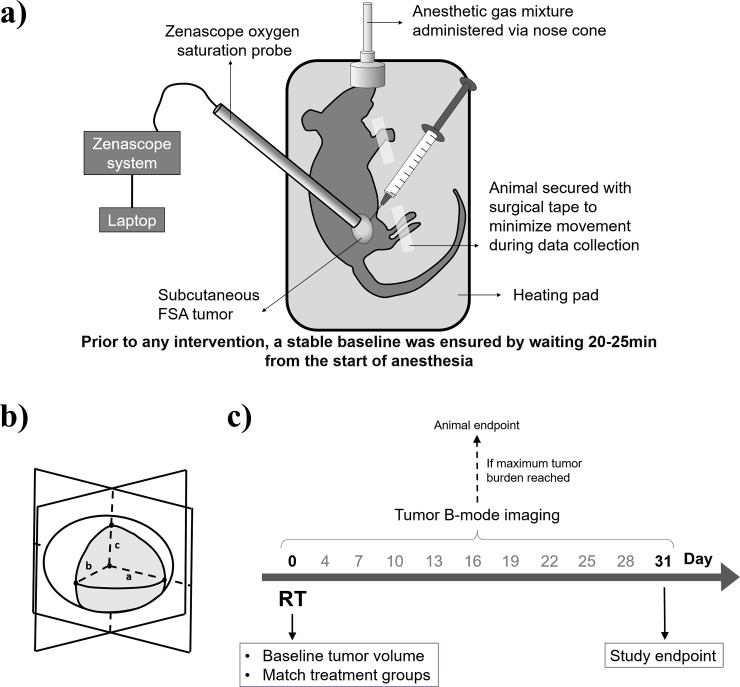
Experimental procedures.a) Schematic of the experimental set-up used for in-vivo hypoxia modulation measurements using the Zenascope system. b) Schematic of tumor volume assessment via B-mode ultrasound imaging. Two cross-sectional images were acquired and lengths a, b and c were used to calculate tumor volume. c) Radiotherapy pre and post-imaging experimental protocol.